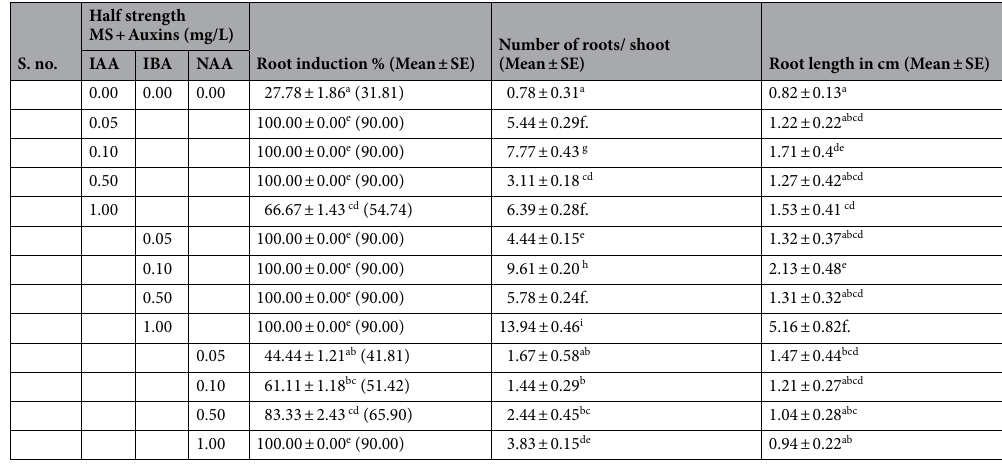
Table 3. Effects of different auxins on in vitro rooting response of Xanthosoma sagittifolium. Data represents mean ± SE of six replicates per treatment in three repeated experiments. Means within the same column followed the different letters are significantly different according to Duncan’s multiple range test (DMRT) at 5% level. Arc sine transformation values are given in parentheses.